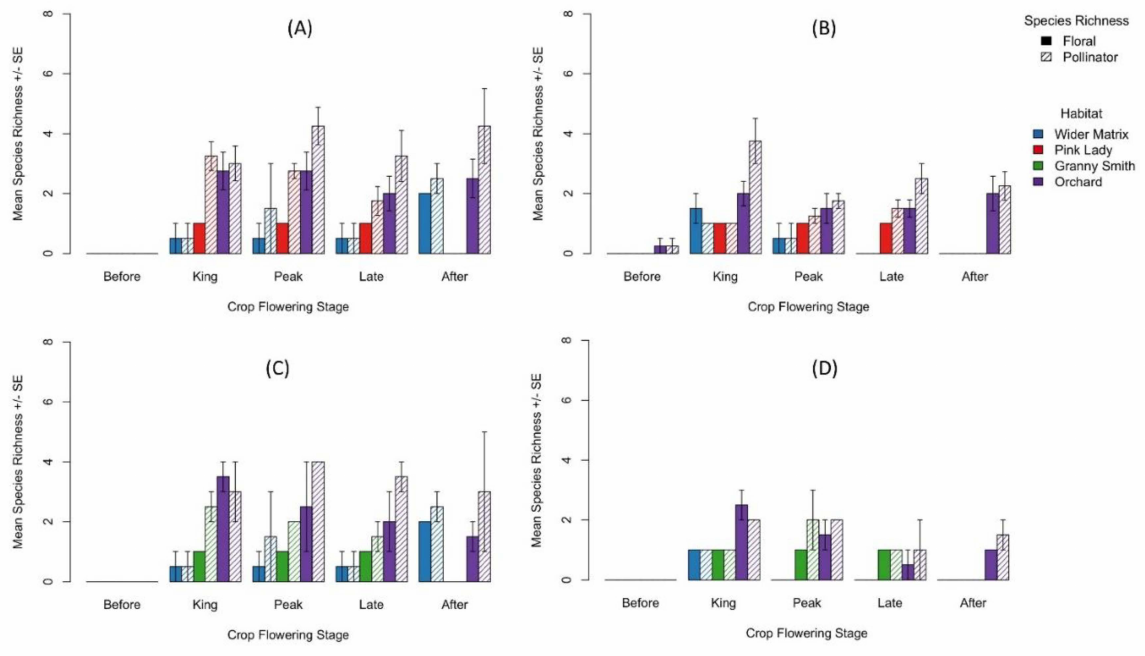
Figure 2. Mean species richness ± standard error of pollinators (solid fill) and flowering plants (hatching) within the surrounding vegetation matrix (blue), within the orchard (purple) and on Pink Lady (red) in 2017 ( A ) and 2018 ( B ) and Granny Smith (green) in 2017 ( C ) and 2018 ( D ) apple flowers (before, king, peak, late and after apple bloom) in